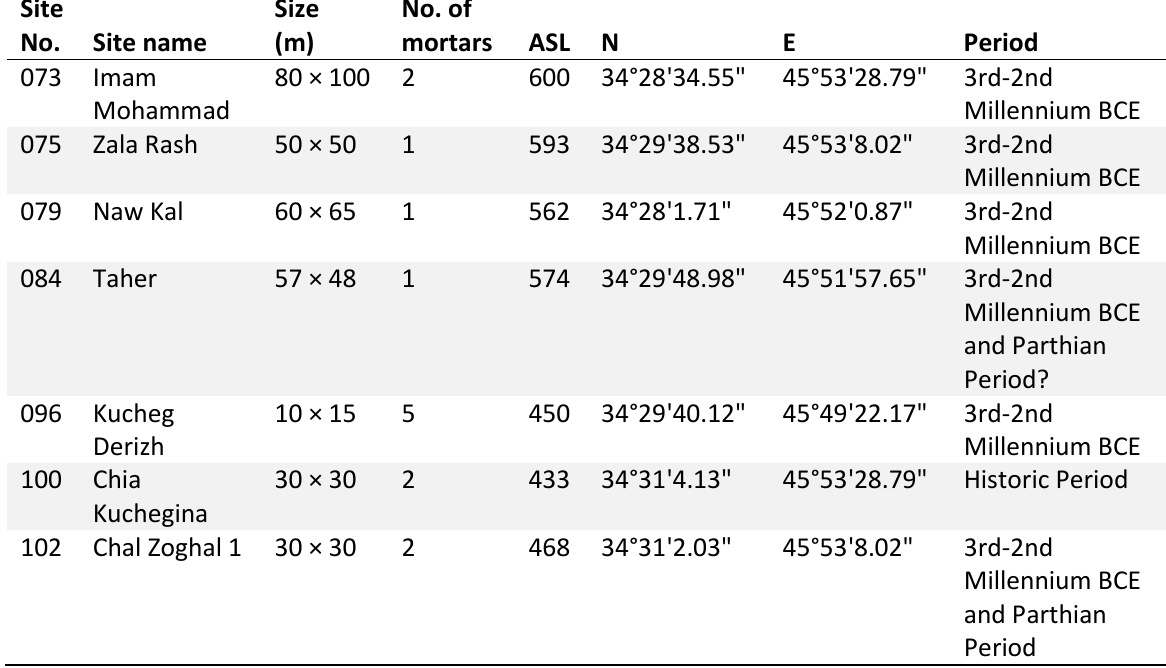
Table. 1. List of sites with rock mortar in Sar Pol-e Zahāb region.